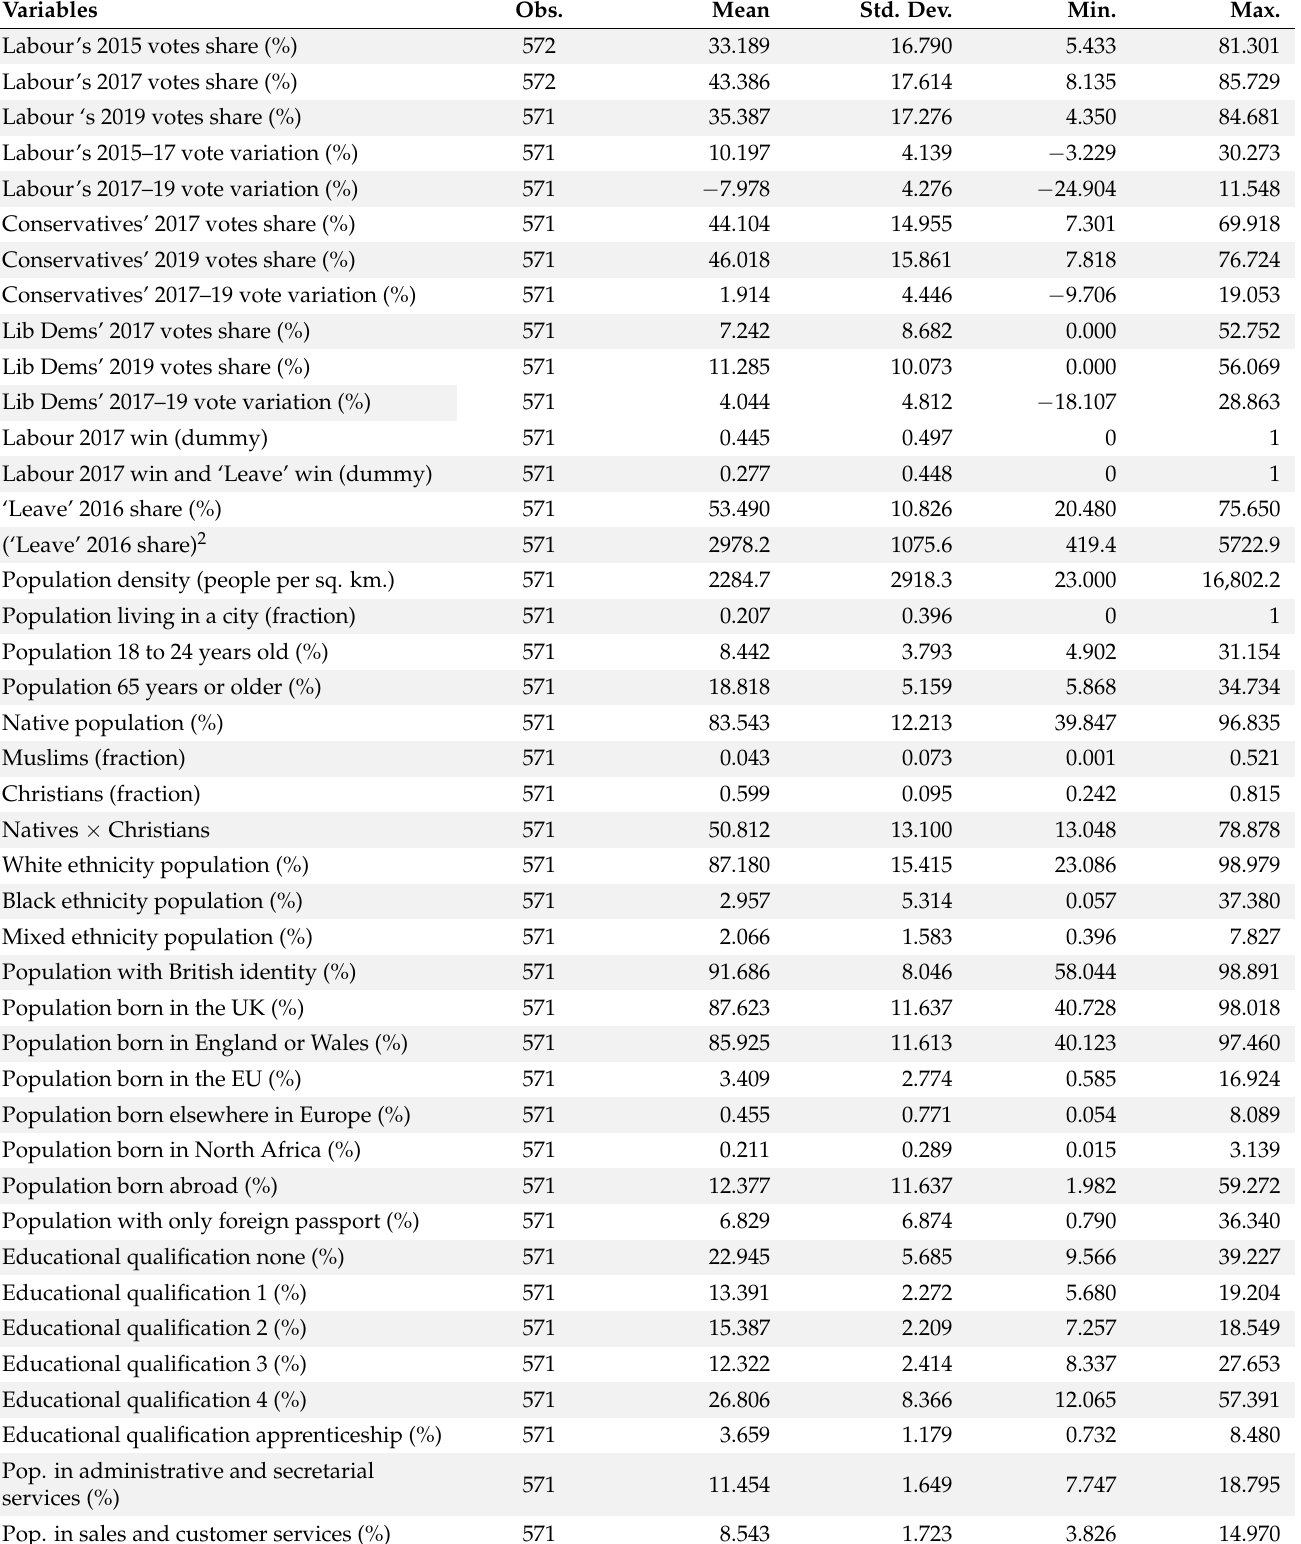
Table A2. List of the variables and summary